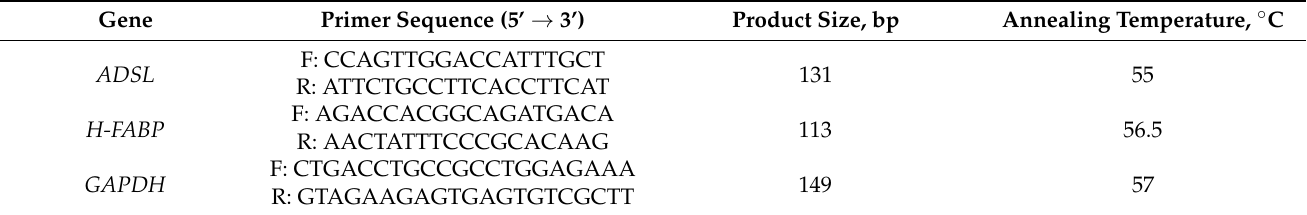
Table 2. Fluorescence quantitative target gene primer-related